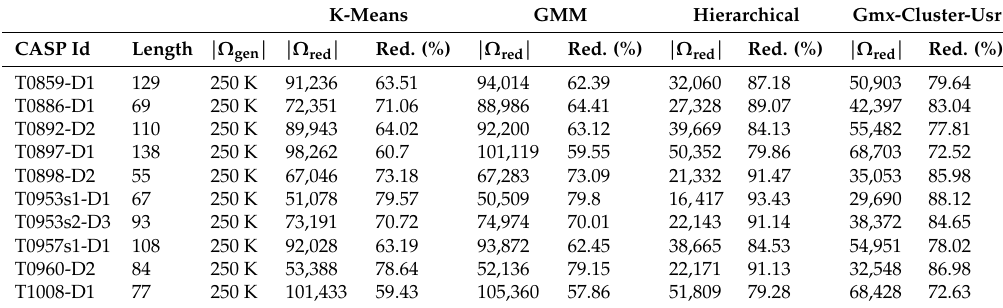
Table 2. Ω gen and Ω red are compared in terms of size over the CASP dataset. The CASP ids and lengths are shown in Columns 1–2. Column 3 shows the size of Ω gen . The size of Ω red and the reduction of Ω Ω gen are shown in Columns 4–11 for all clustering red over